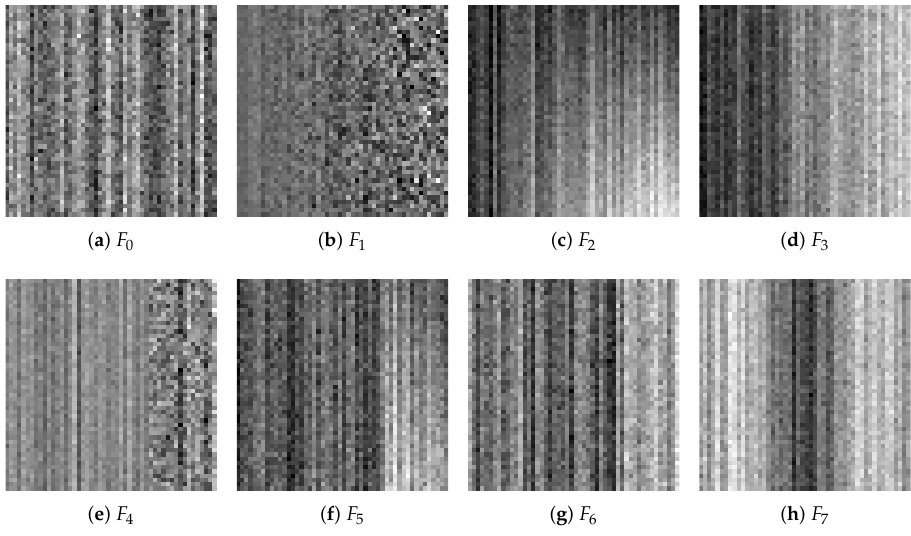
Figure 4. Normal and abnormal process images in the pasting process.